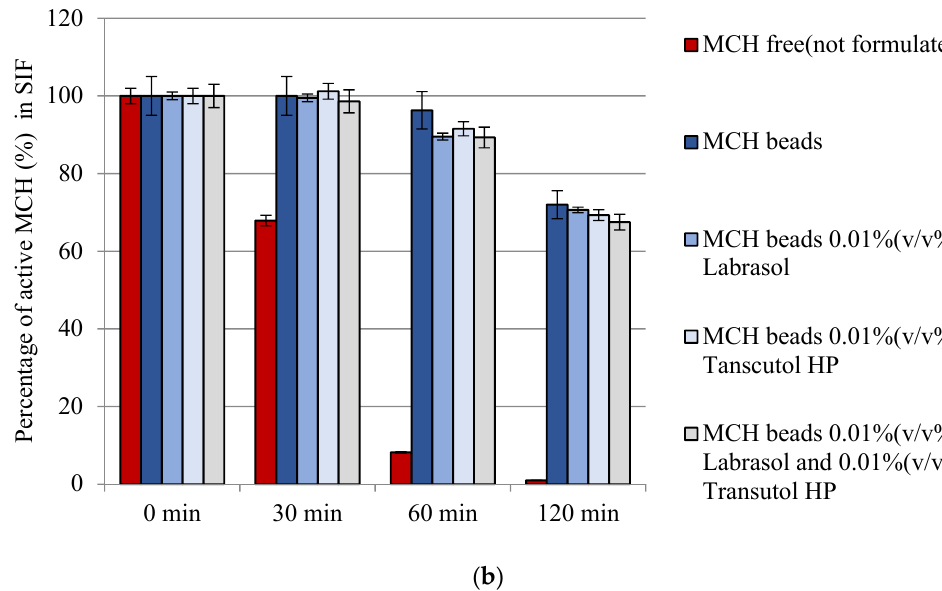
Figure 6. Enzymatic stability of melanin concentrating hormone (MCH) encapsulated in sodium- alginate beads with free (not formulated) MCH as a control: ( a ) in SGF medium; ( b ) in SIF medium. Each data point represents the mean ± SD, n = 3.